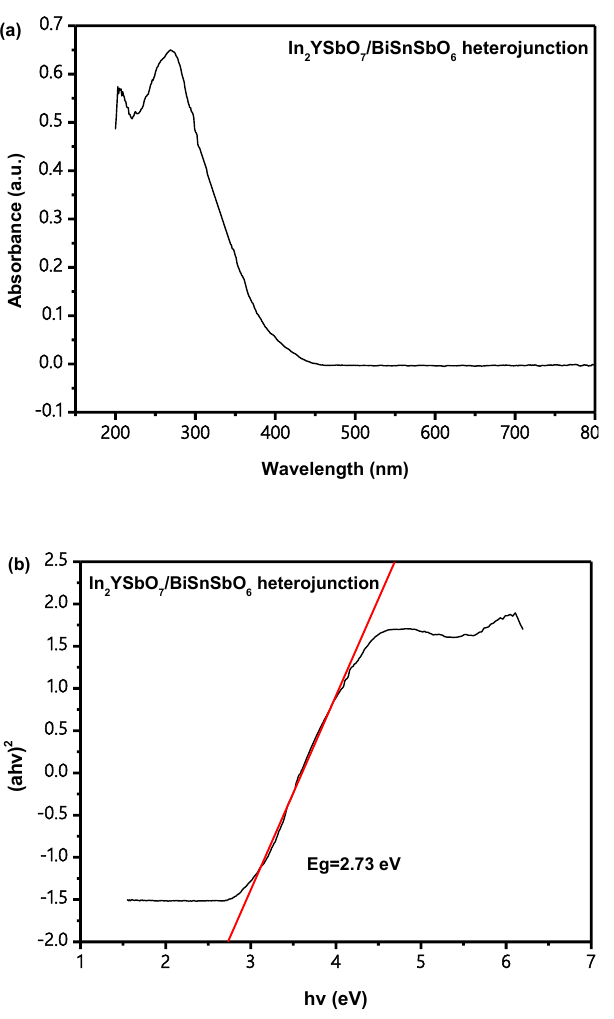
Figure 8. ( a ) The diffused reflection spectrum of In 2 YSbO 7 /BiSnSbO 6 heterojunction; ( b ) Correlative diagram of ( α h ν ) 2 and h ν for In 2 YSbO 7 /BiSnSbO 6 heterojunction. The U – V DRS of TiO 2 and N-TiO 2 under different calcination temperatures are shown in Figure 9. In accordance with above procedures and Figure 9, the numerical value of Eg for pure TiO 2 or N-TiO 2 was calculated to be 3.13 eV or 2.95 eV.